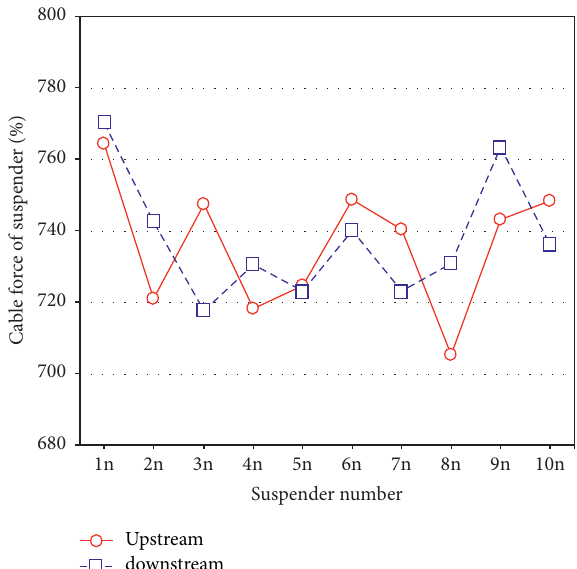
Figure 27: Calculated cable force of suspender Nos.1–10 after correction.